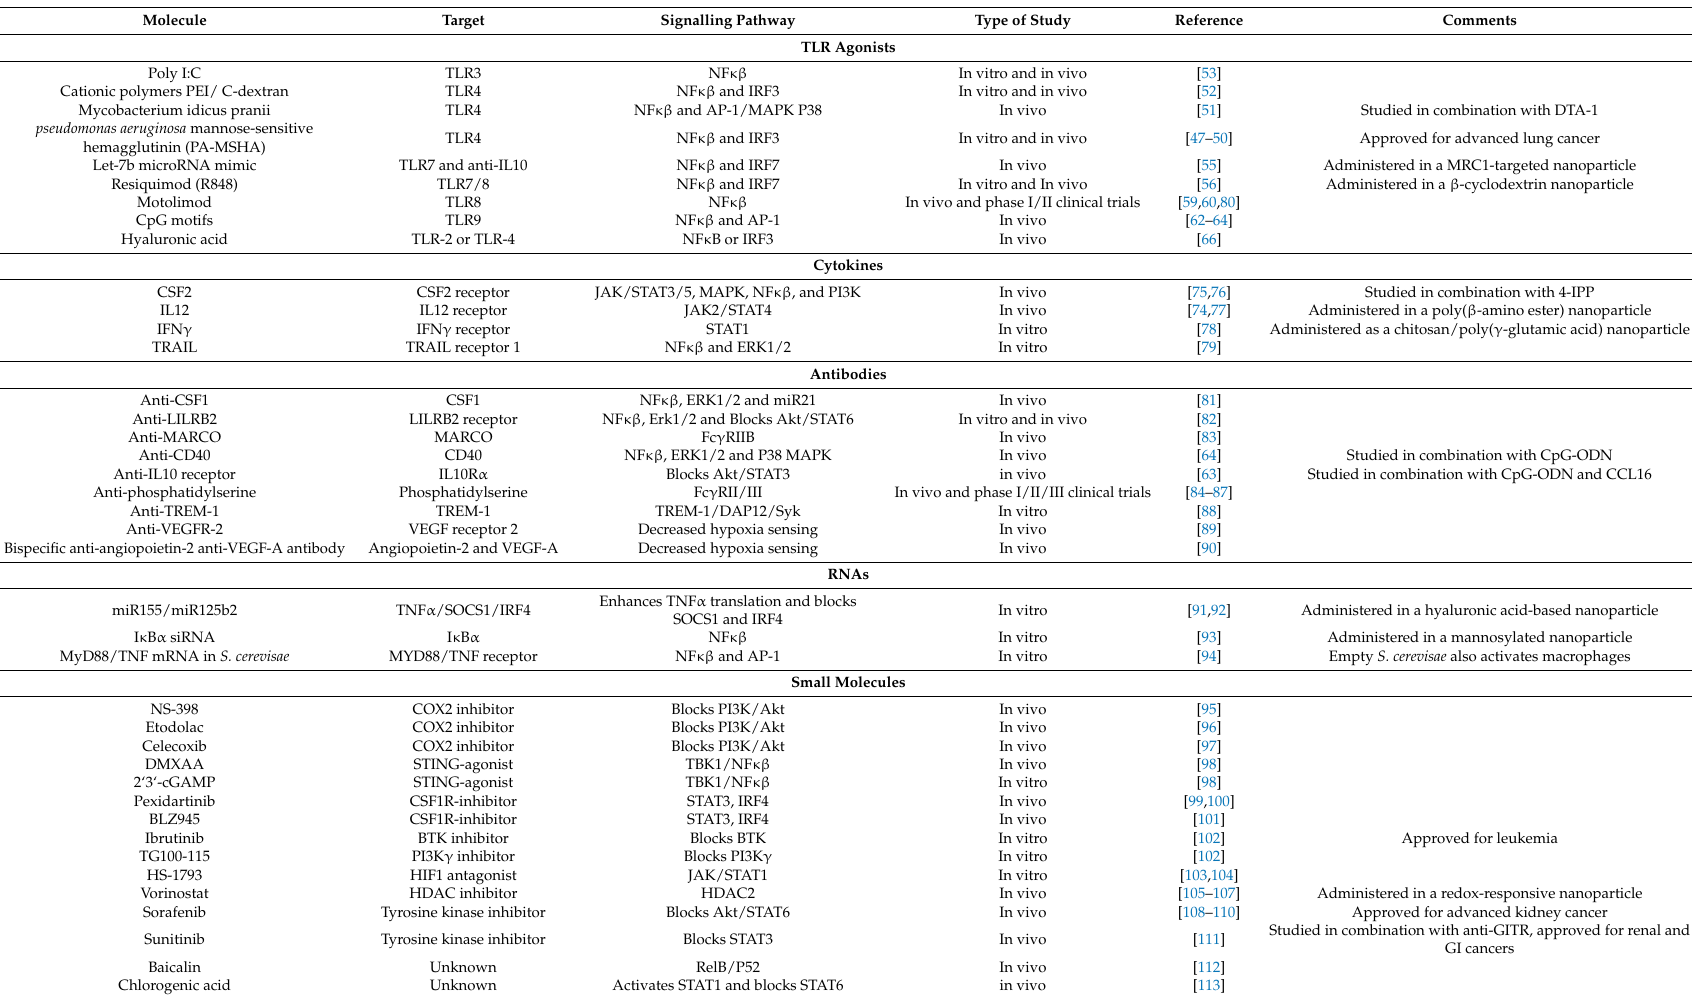
Table 1. TAM reprogramming